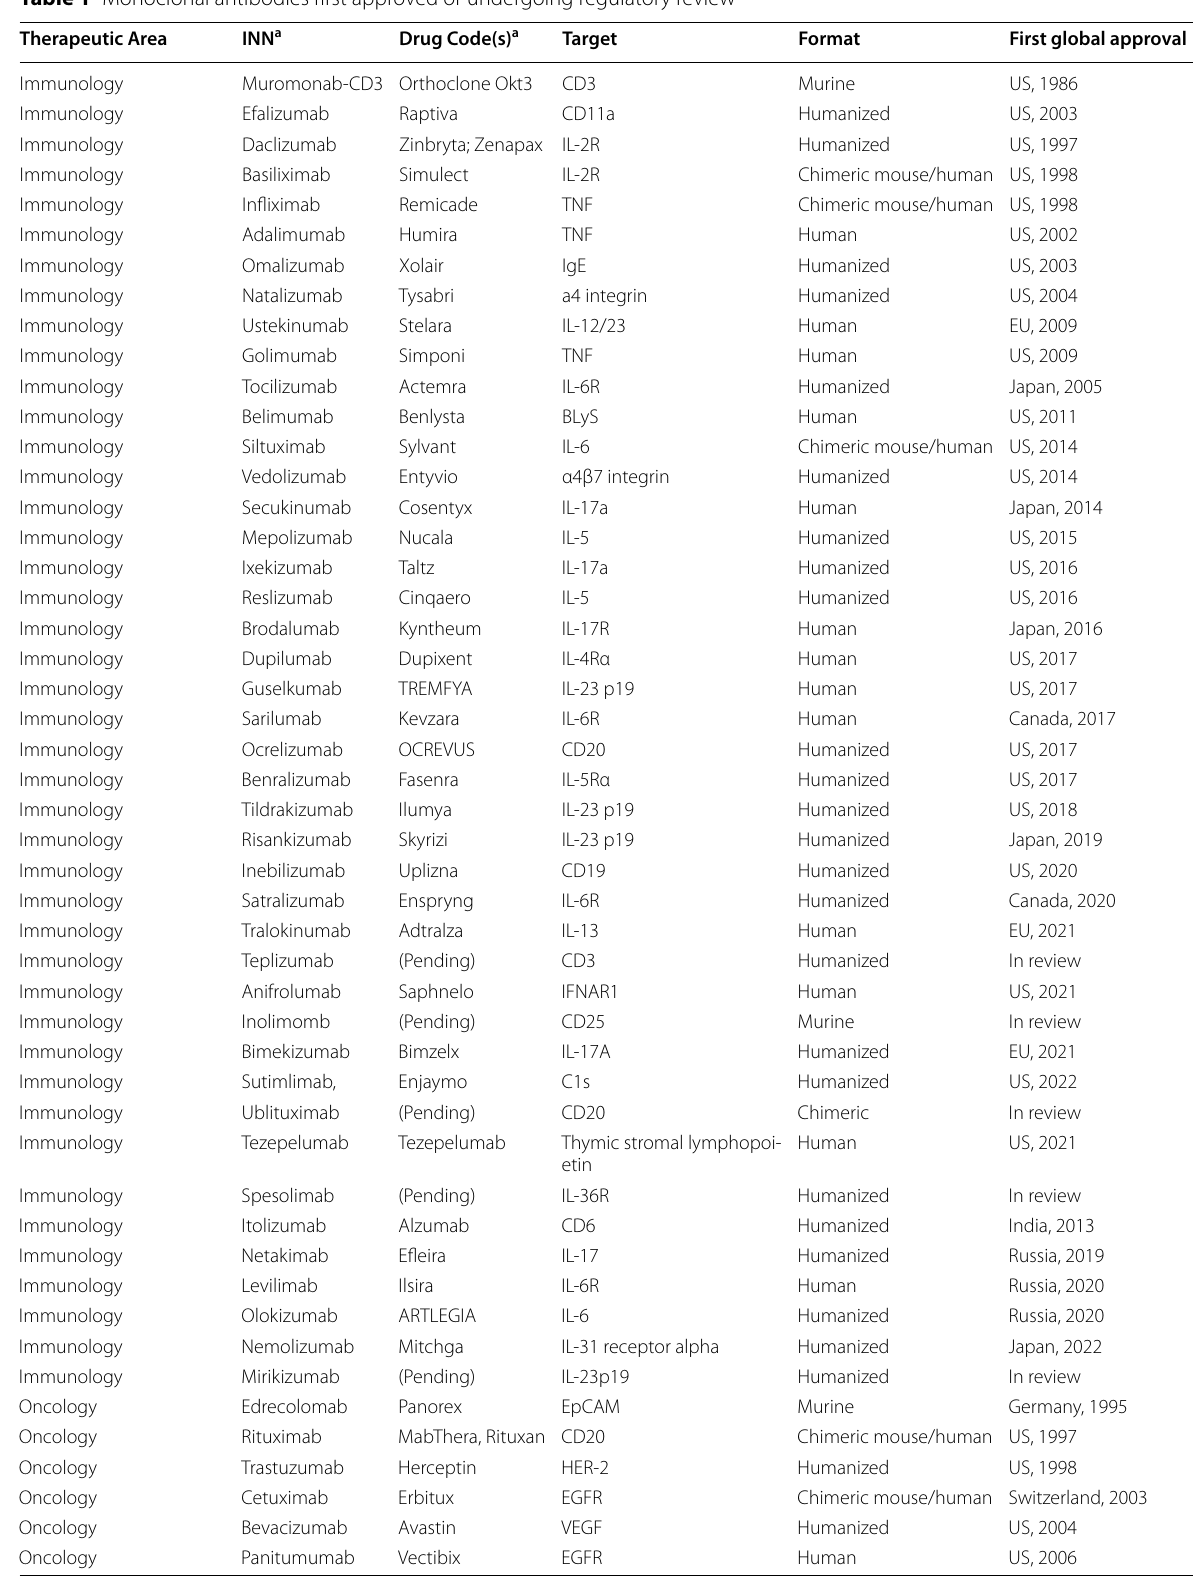
Table 1 Monoclonal antibodies first approved or undergoing regulatory review b